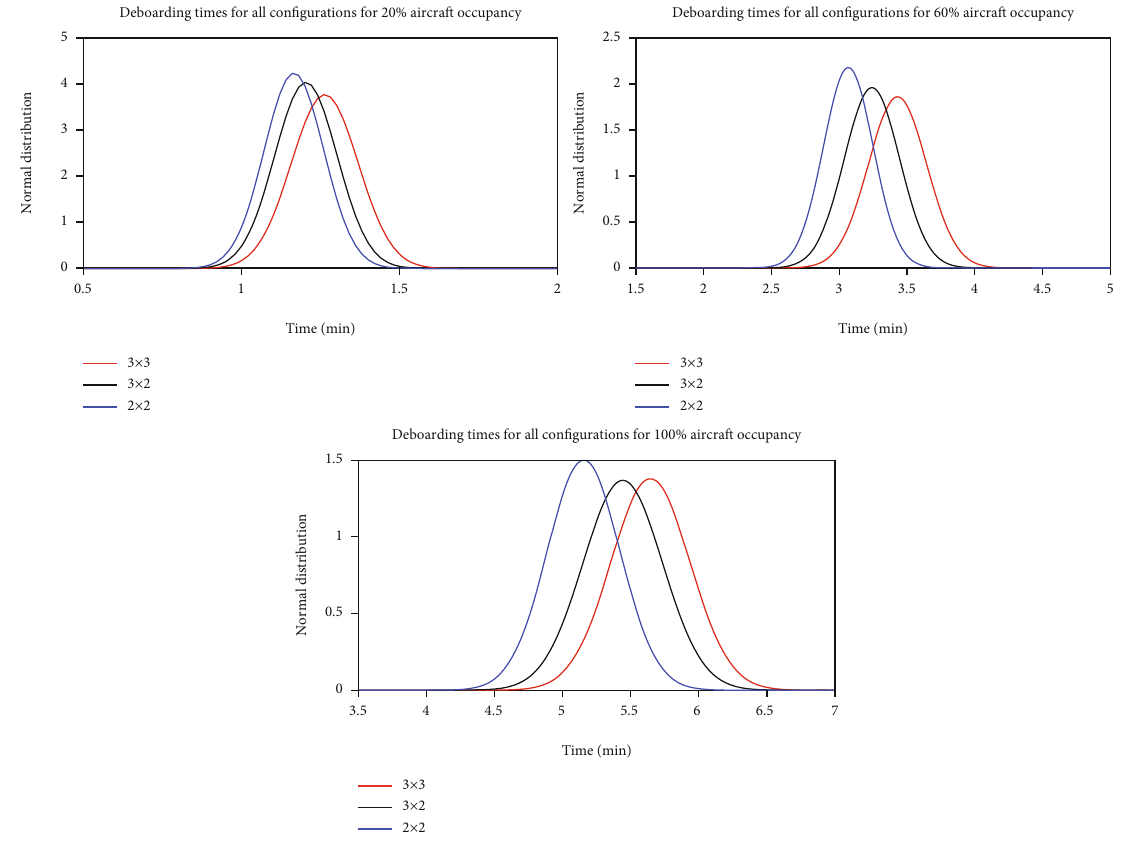
Figure 10: Fitted normal distribution curves for deboarding for each aircraft con fi guration for di ff erent % of aircraft